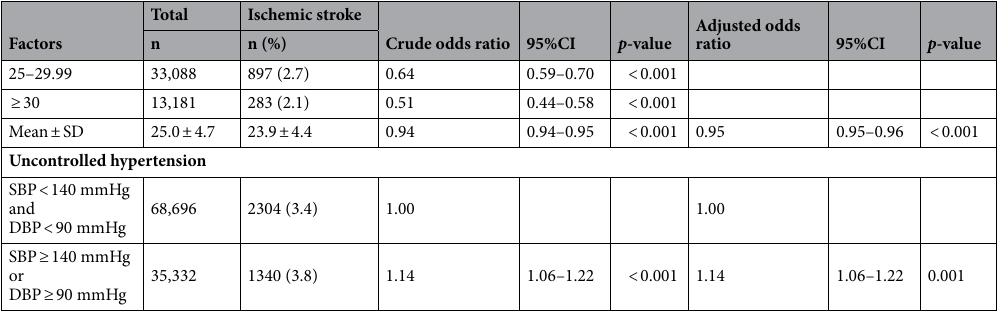
Table 3. Univariable and multivariable analyses for factors associated with ischemic stroke among Thai patients with hypertension. The level of statistical significance is set at p <